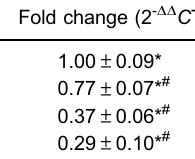
Table 1. Relative expression of SCF mRNA in rat intestinal tissue. Groups